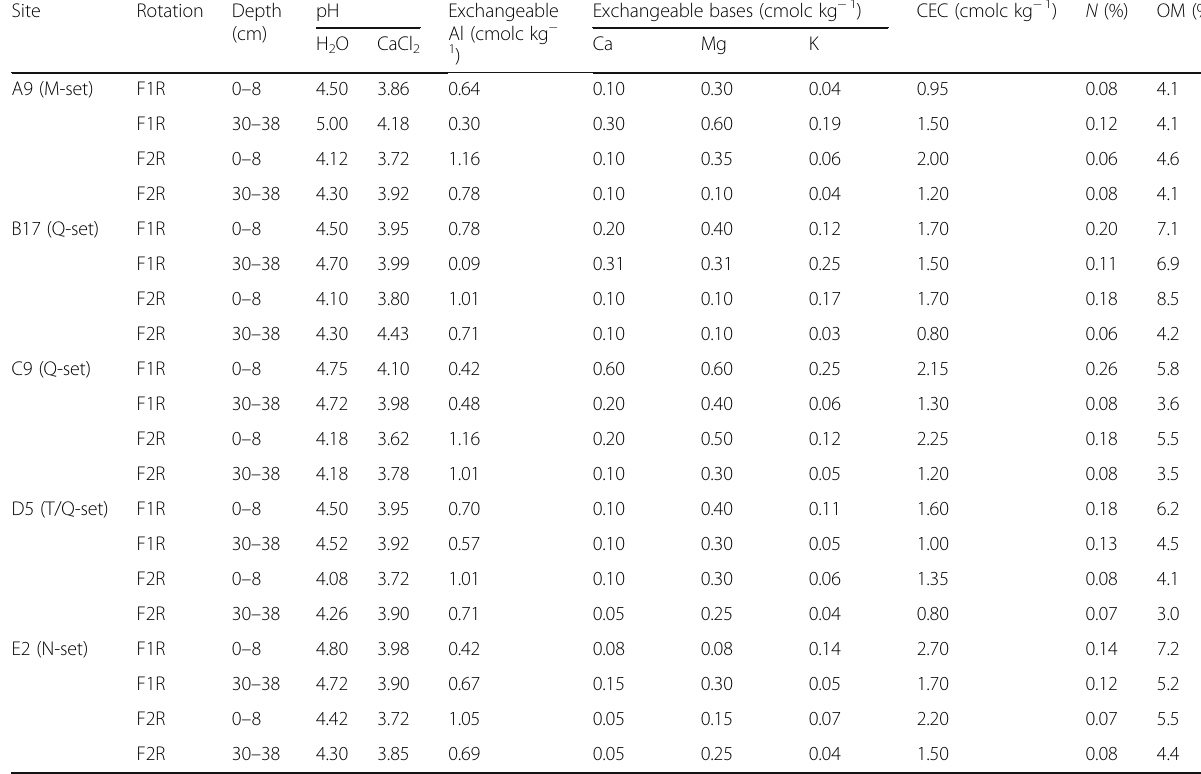
Table 2 Soil chemical characteristics of the five compartment soil sets, at the establishment of the first and second rotations of the first trial series; adapted from Germishuizen (1979)